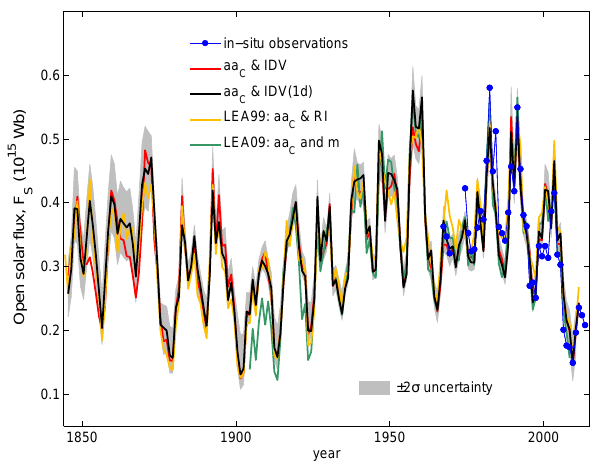
Fig. 9. Variations of annual means of the kinematically corrected signed open solar flux, F S . Reconstructions use IDV(1d) and aa C (black); IDV and aa C (red); aa C and RI using the method of Lock- wood et al. (1999) (orange); aa C and the m index as derived by Lockwood et al. (2009c) (grey-green). The blue dots give annual means from satellite observations and the grey band shows the 2 σ uncertainty band determined from the Monte Carlo analysis, as ap- plied to B and V SW